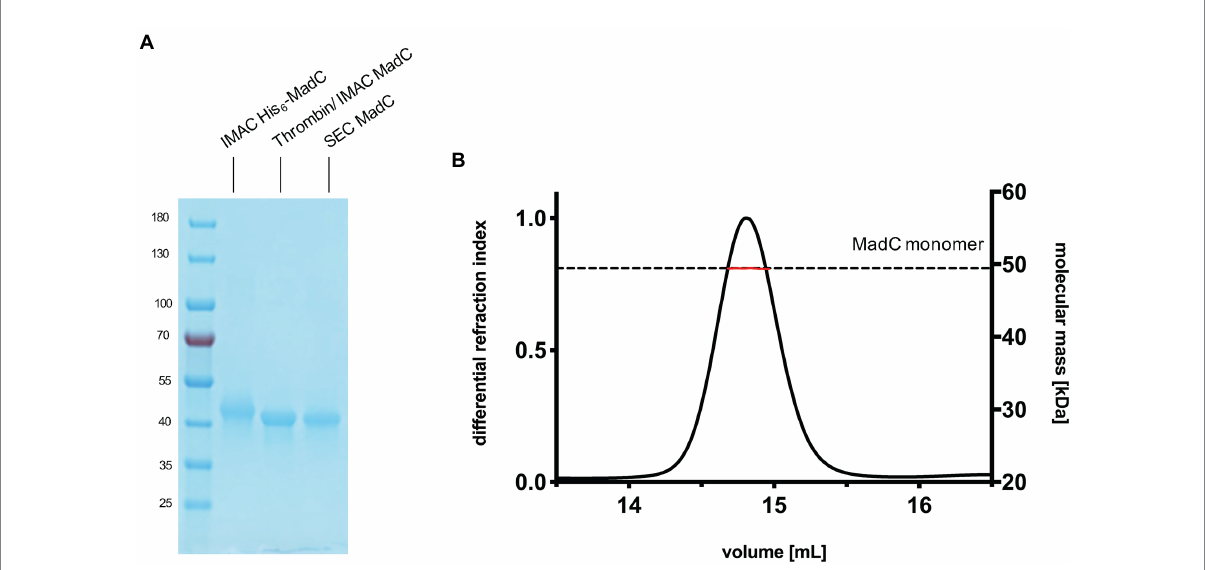
FIGURE 1 Purification of the cyclase MadC from Clostridium maddingley . (A) SDS-PAGE of samples taken during the purification of MadC. Marker: PageRuler Prestained Protein Ladder (Thermo Fisher Scientific), molecular weights in kDa are indicated. (B) SEC-MALS chromatogram of purified